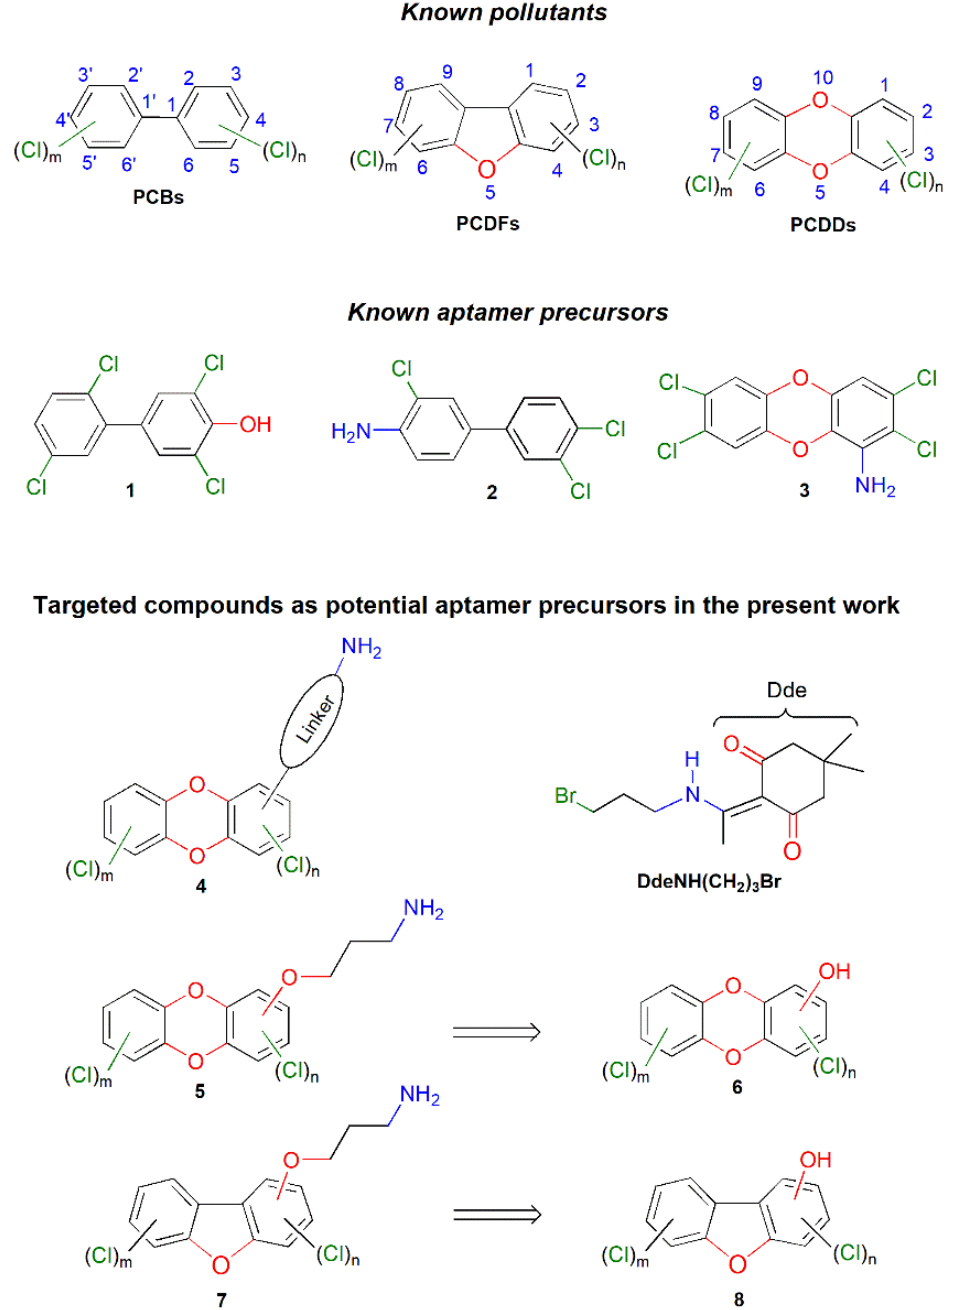
Figure 1. Structures of dioxins and related compounds referred to in this work.